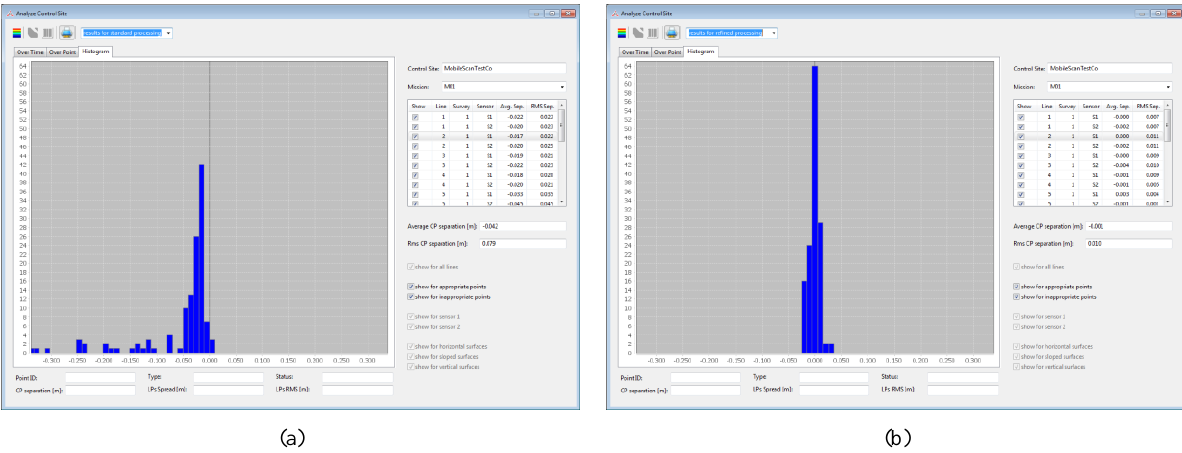
Figure 6. Separation between lidar data and control points in the form of a histogram before (a) and after (b) the post-mission QA